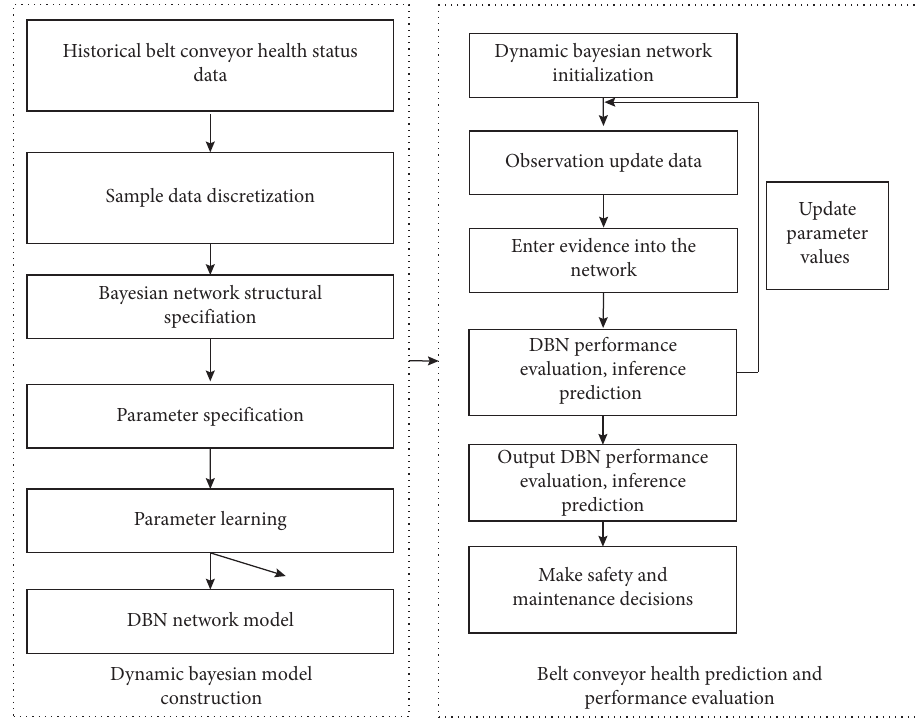
Figure 3: Mode application flow chart.